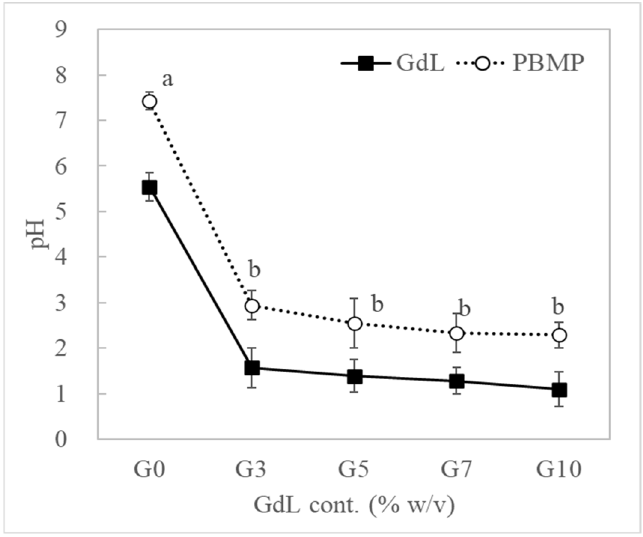
Figure 3. Comparison of pH value of GdL solution and PBMP depends on the GdL concentration.